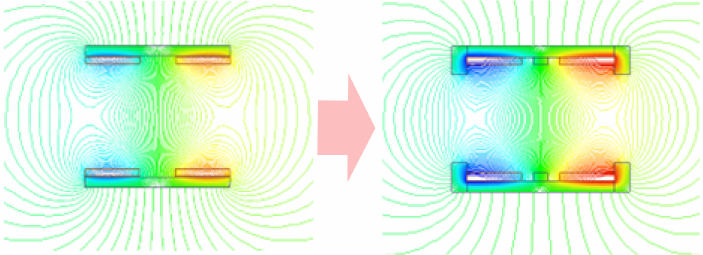
Figure 15. Distribution of magnetic field lines before and after aggregated